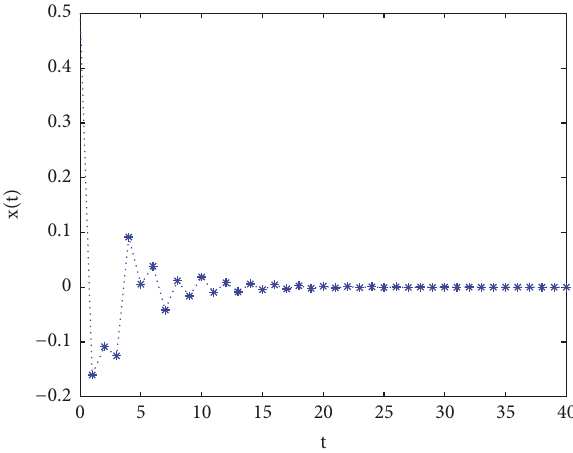
Figure 1: System state response in Example